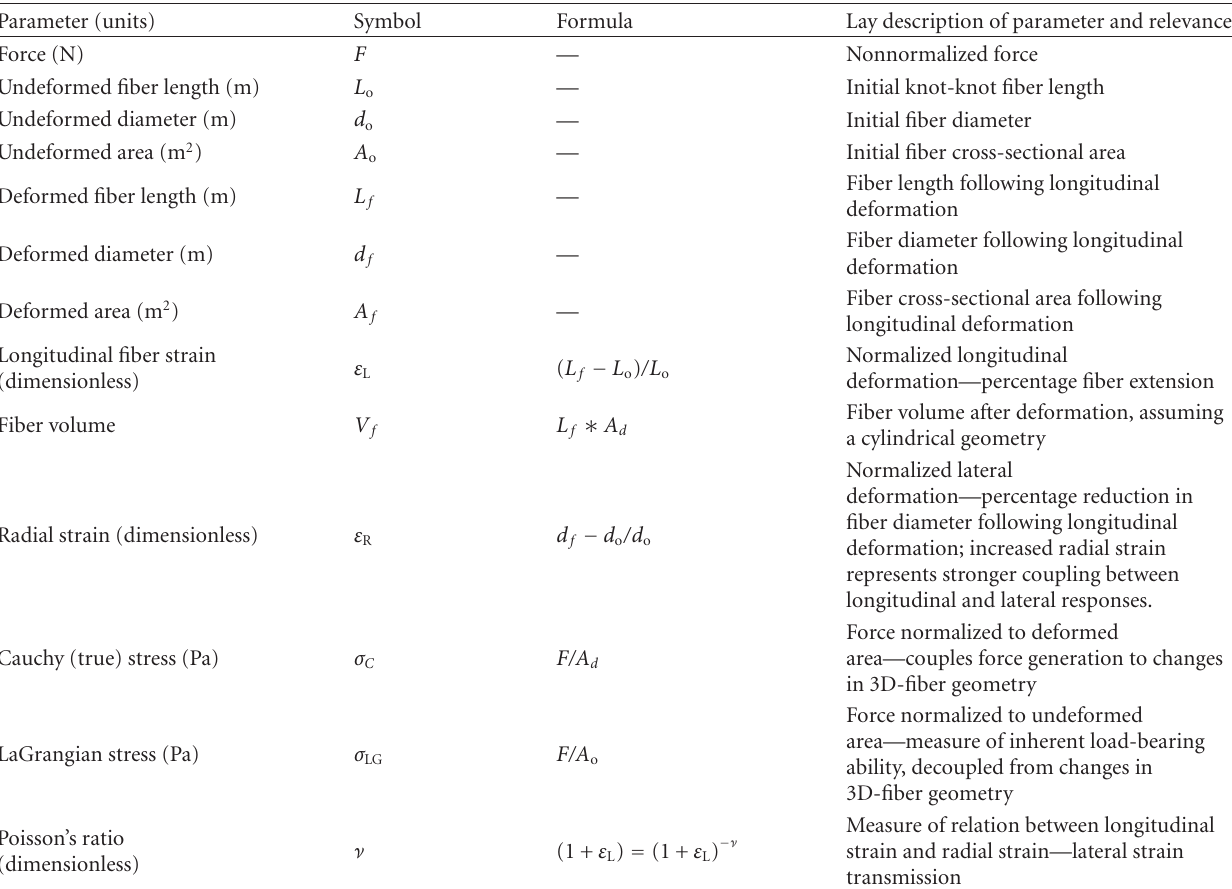
Table 1: Summary and explanation of biomechanical parameters.